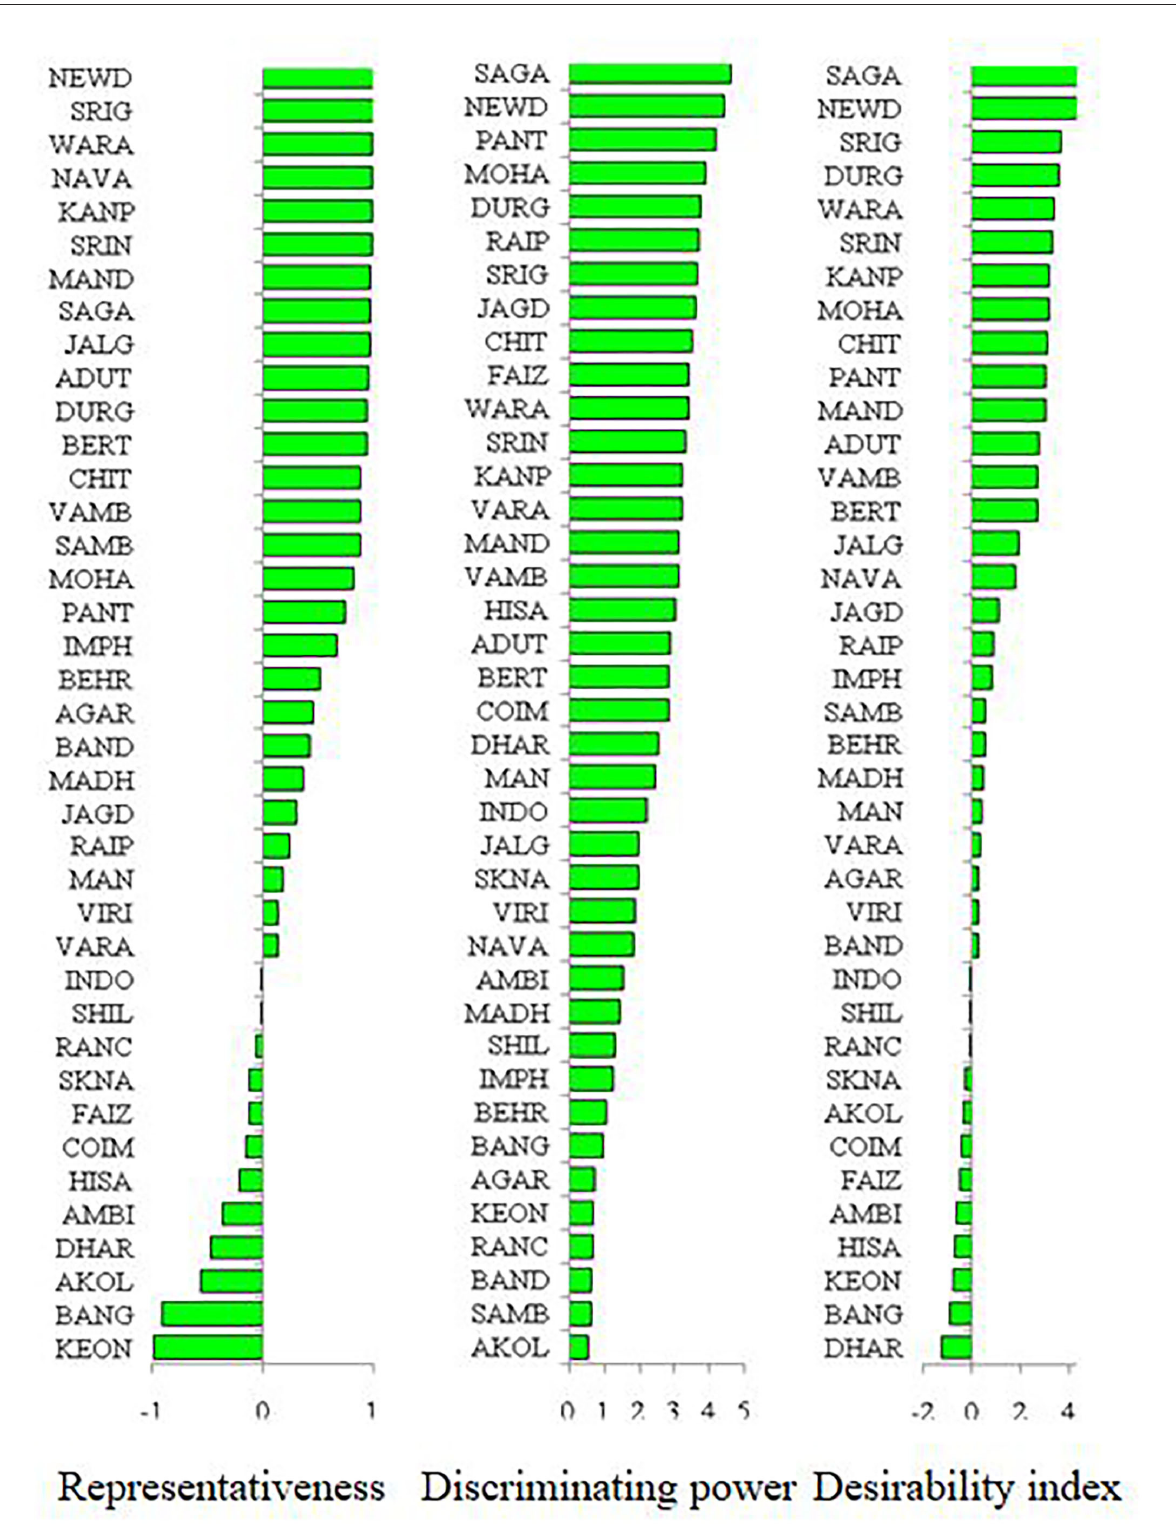
FIGURE9 Representativeness, discriminating power, and desirability index of different locations. Please see Supplementary Table 1 for environment (E1–E39) detail.